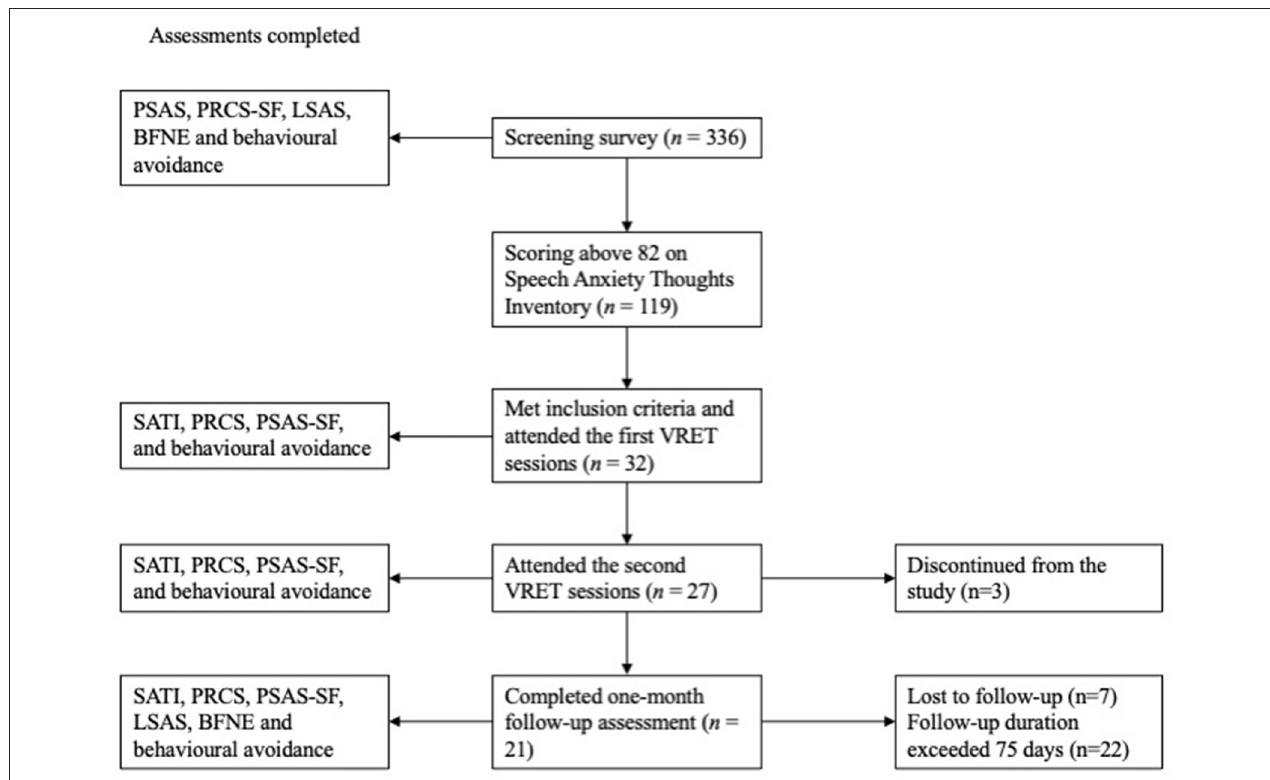
FIGURE 2 | Flow diagram of participant retention at each stage of the study; BFNE, brief fear of negative evaluation scale; LSAS, Liebowitz social anxiety scale; PRCS-SF, personal report of confidence as a speaker; PSAS-SF, Public-speaking anxiety scale—short form; SATI, speech anxiety thoughts inventory; SUDS, subjective units of distress